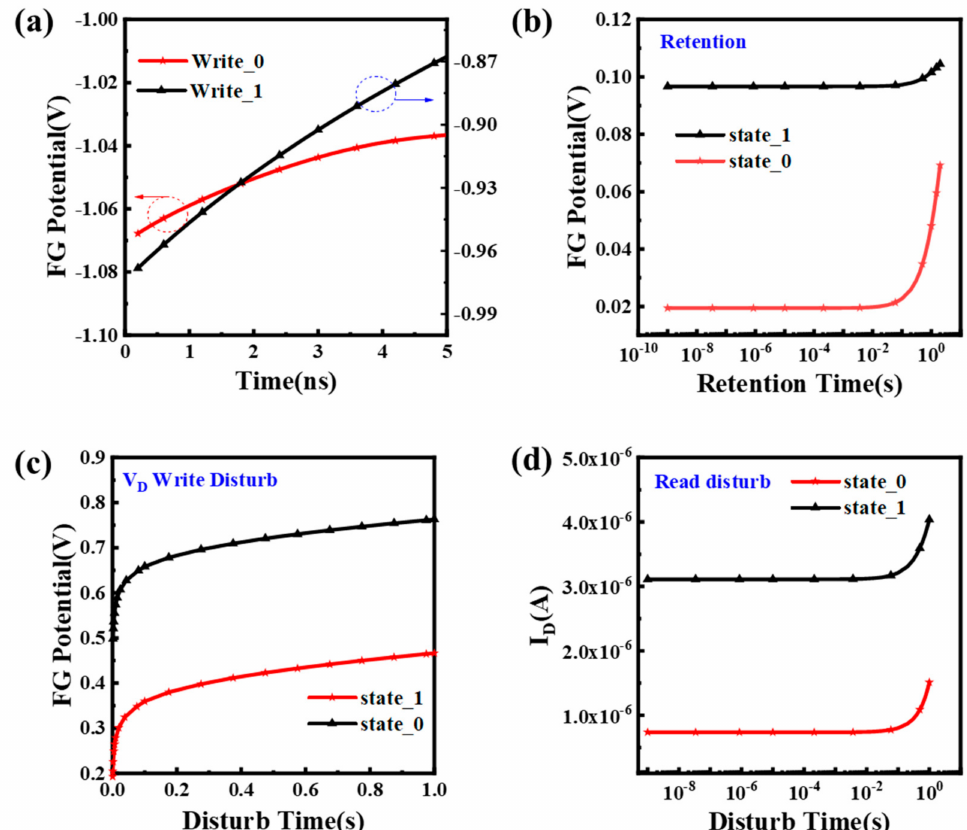
Figure 5. ( a ) The changes in the FG potential of the HDM with different write-0 and write-1 times with fixed voltages. ( b ) FG potential of state-0 and state-1 extracted at different retention times. ( c ) V D write-1 disturb performance of state-0 and state-1. ( d ) V D read disturb performance of state-0 and